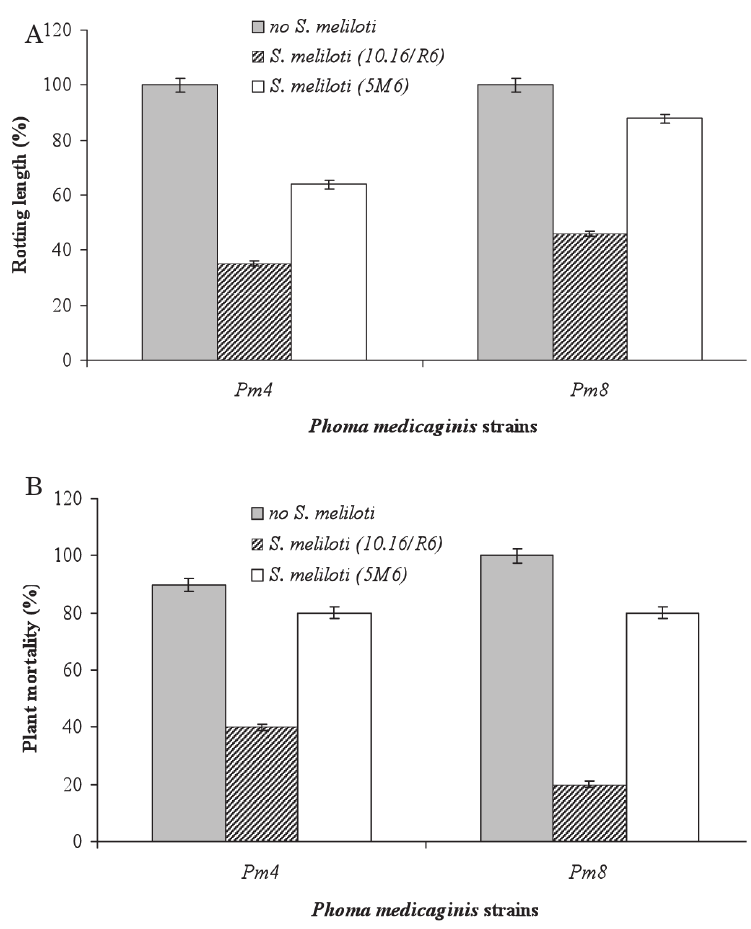
Figure 3. Disease symptom development in Medicago truncatula JA17 (at 21 days) in an assay of biocontrol activity of Sinorhizobium meliloti against Phoma medicaginis . A, rotting length development in plantlets infected with P. med- icaginis ( Pm 4 or Pm 8) in presence or absence of S. meliloti strains with different activities against P. medicaginis; B, plant mortality in presence or absence of the S. meliloti strains. Plantlets without P. medicaginis inoculation survived without any rotting symptoms. Each treatment corresponds to 15 replicates. Bars represented standard